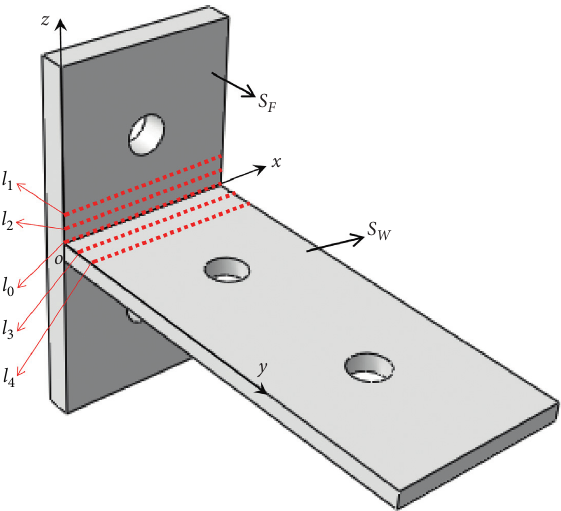
Figure 12: The typical paths of T